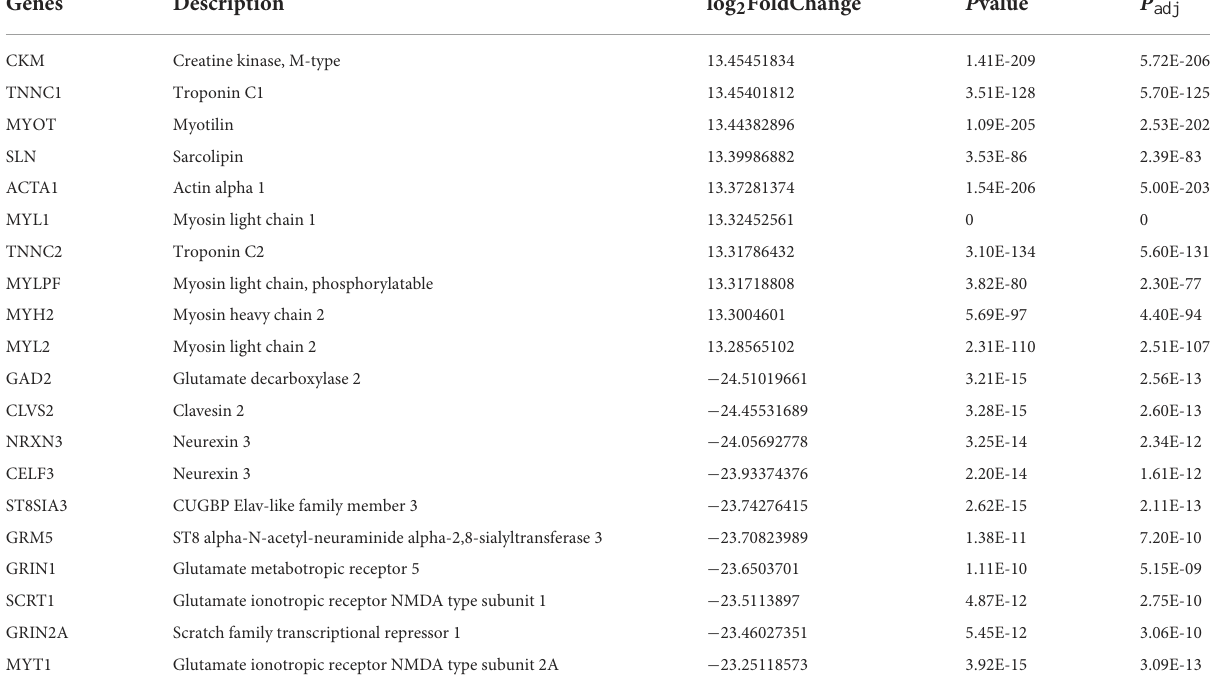
TABLE 1 Top 10 up- and down-regulated expressed genes.